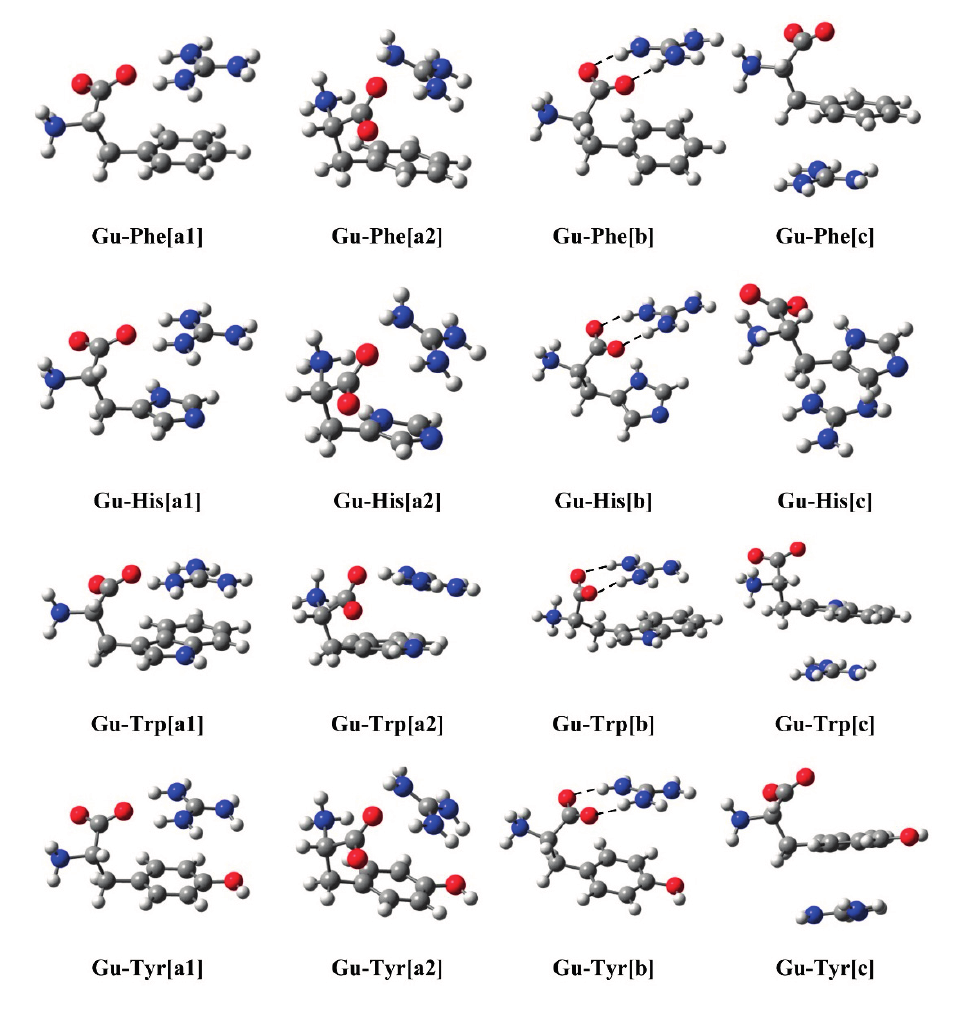
Figure 1. Optimized geometry of the complexes studied at the M06-2X/6-311++G(d,p)